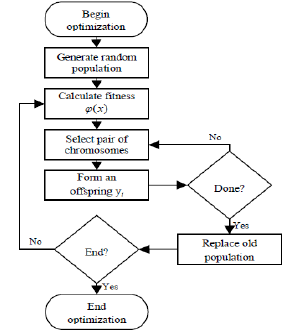
Figure 1: Flowchart of genetic algorithm ( Source: Paulinas, Ušinskas